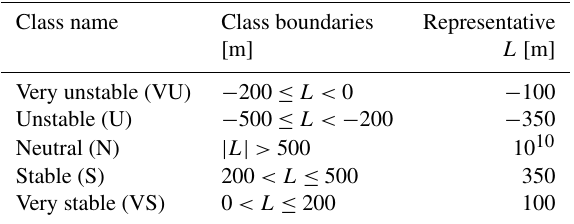
Table 1. Stability classes in terms of the Obukhov length, adapted from Holtslag et al.